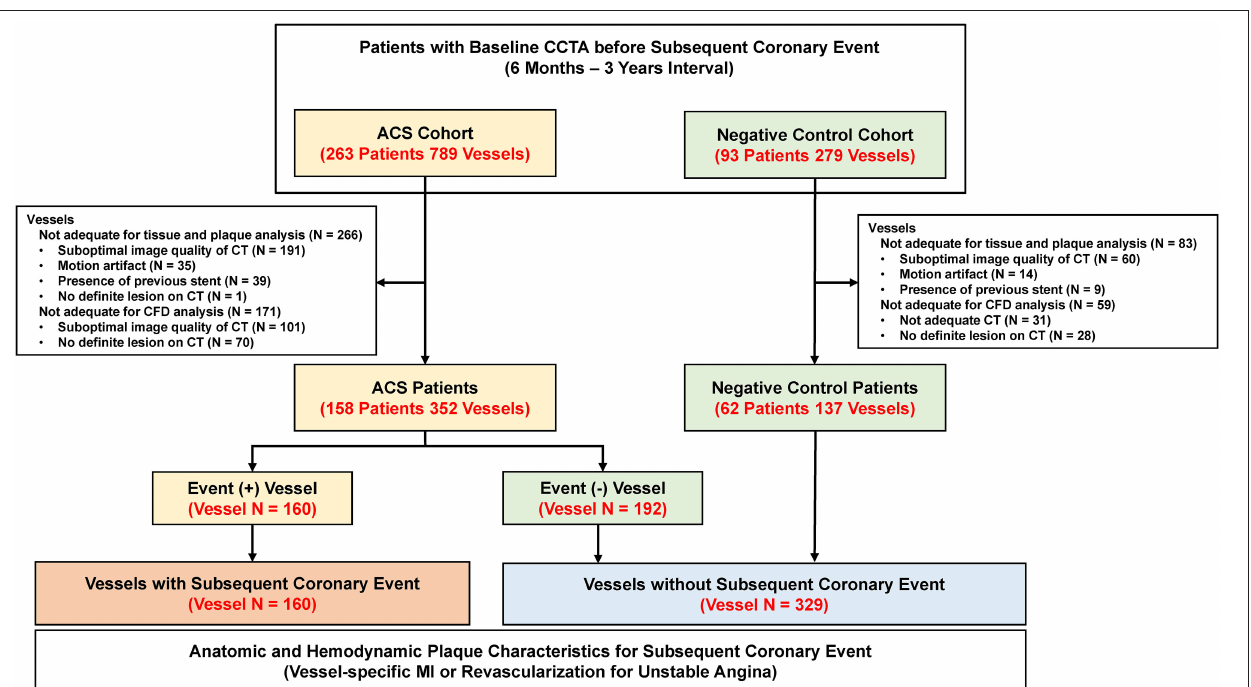
FIGURE 1 | Study flow. This study enrolled two separate patient populations (ACS and negative control cohort). The ACS cohort included consecutive patients who underwent CCTA within 6–36 months before PCI for acute myocardial infarction or unstable angina. The negative control cohort included age-/sex-matched patients who underwent CCTA within 6–36 months before invasive coronary angiography for suspected stable angina but did not undergo PCI because there was no significant lesion at the time of angiography. A total of 489 vessels (160 vessels with subsequent coronary event and 329 vessels without subsequent coronary event) were finally included in the study. ACS, acute coronary syndrome; CCTA, coronary computed tomography angiography; CFD, computational fluid dynamics; CT, computed tomography; PCI, percutaneous coronary